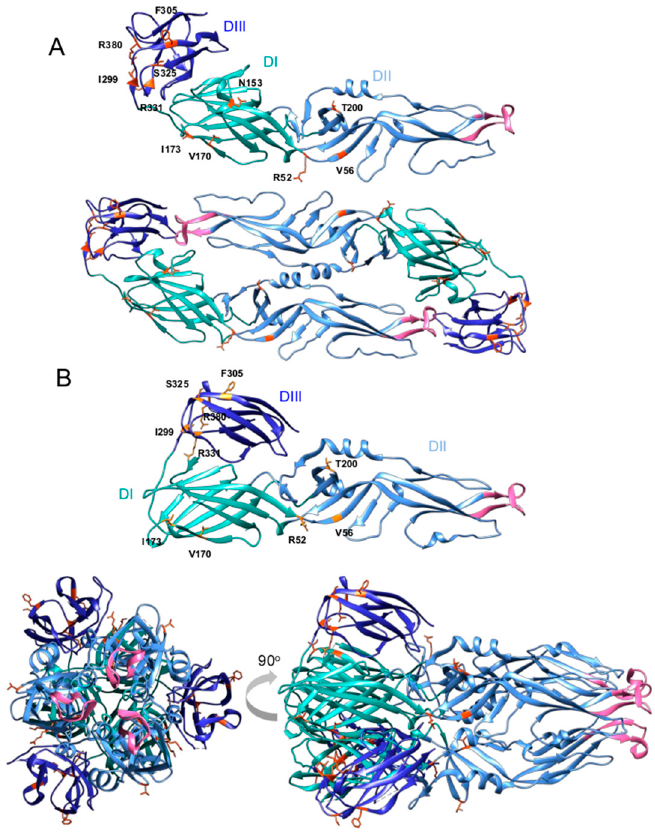
Figure 2. YFV E protein structures with 17D attenuating mutations and fusion peptide highlighted. ( A ) The structure of the YFV-17D E protein pre-fusion monomer is presented with DI, DII and DIII highlighted in different colors. YFV-17D-attenuating mutations are highlighted on the E structure in orange while the fusion peptide is highlighted in pink. Pre-fusion E dimers are presented directly below. ( B ) The structure of the YFV-17D E protein post-fusion monomer is presented with DI, DII and DIII, highlighted in different colors. Again, attenuating mutations are highlighted on the structure in orange while the fusion peptide is highlighted in pink. Post-fusion E trimers are positioned directly below with both top (left) and side (right) views presented. The YFV E structures presented were previously described in [54] (PDB IDs: 6IW1 and 6IW4) and the presented figures were generated in UCSF Chimera [55].